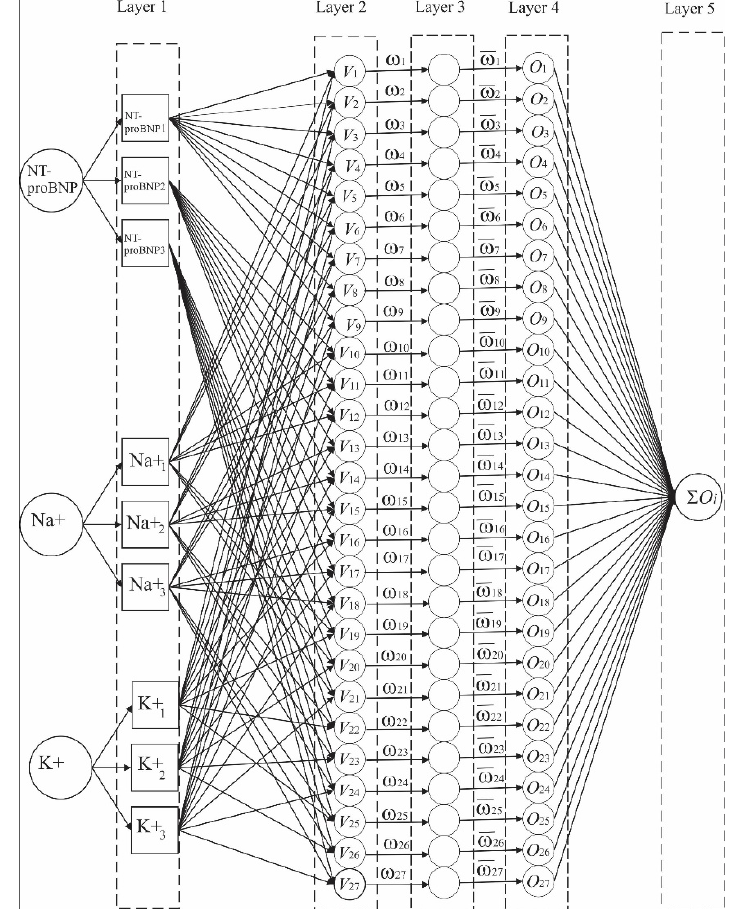
Figure 1. Representation of the ANFIS network used for training on BPU, Na+, K+ parameters with the aim of obtaining EF (%) or CKD-EPIcystatin C as control parameters of cardiac and renal function.